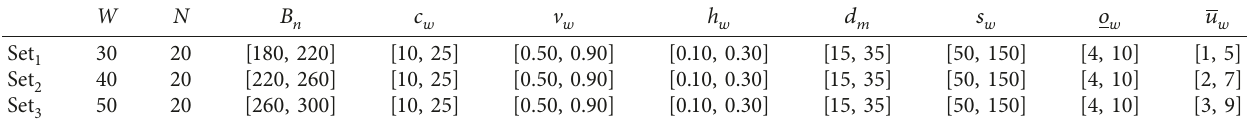
Table 1: Parameters of test instance